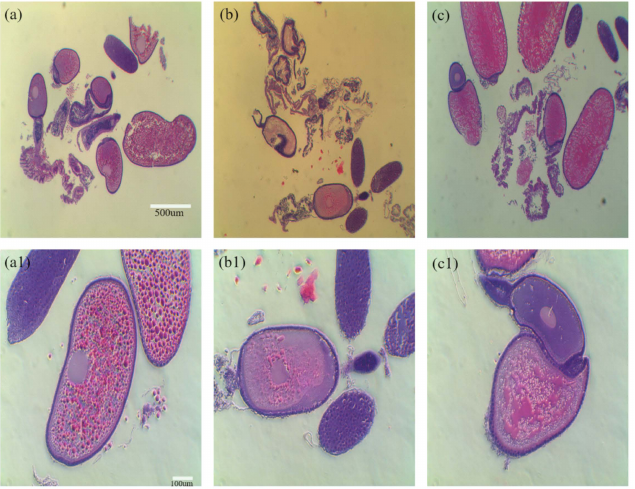
Figure 7. Comparison of the freezing methods used for ovaries isolated from female adult